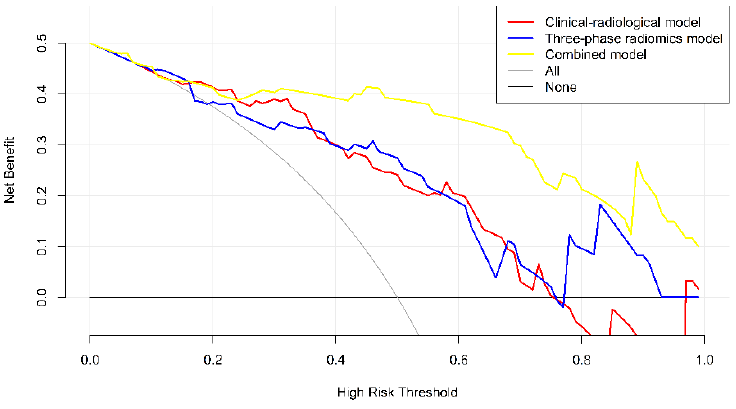
Figure 6. Decision curve analysis for the nomograms of the clinical–radiological and combined models. The black line represents the assumption that no patients have LNM. The gray line represents the assumption that all patients have LNM. The red line represents the net benefit at different threshold probabilities of the clinical–radiological model. The blue line represents the net benefit at different threshold probabilities of the three-phase radiomics model. The yellow line represents the net benefit at different threshold probabilities of the combined model. Among the three models, the combined model showed the highest overall net benefit. Abbreviations: LNM, lymph node metastasis; PTC, papillary thyroid carcinoma.